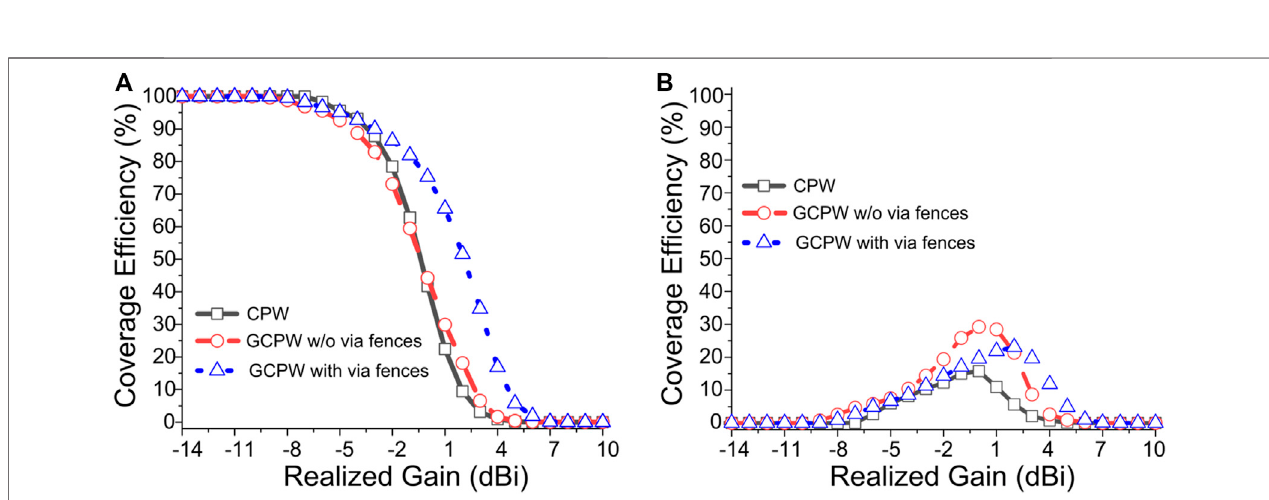
FIGURE 14 | Statistical investigation (Frequency ranges from 26 to 36 GHz) of the simulated coverage ef fi ciency of the designed array antennas in the handset mockup. (A) Average value. (B) Standard deviation value.